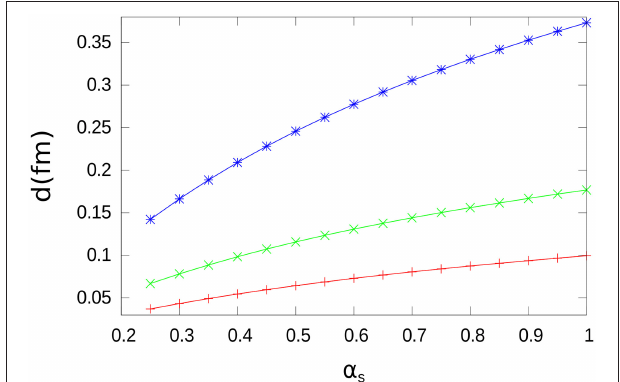
FIGURE 3 | The parameter d is plotted as a function of α s . The results of the numerical calculation are indicated by points, joined by lines for convenience. As before, red, green, and blue refer to exponential, Gaussian, and step-wise distributions, respectively.